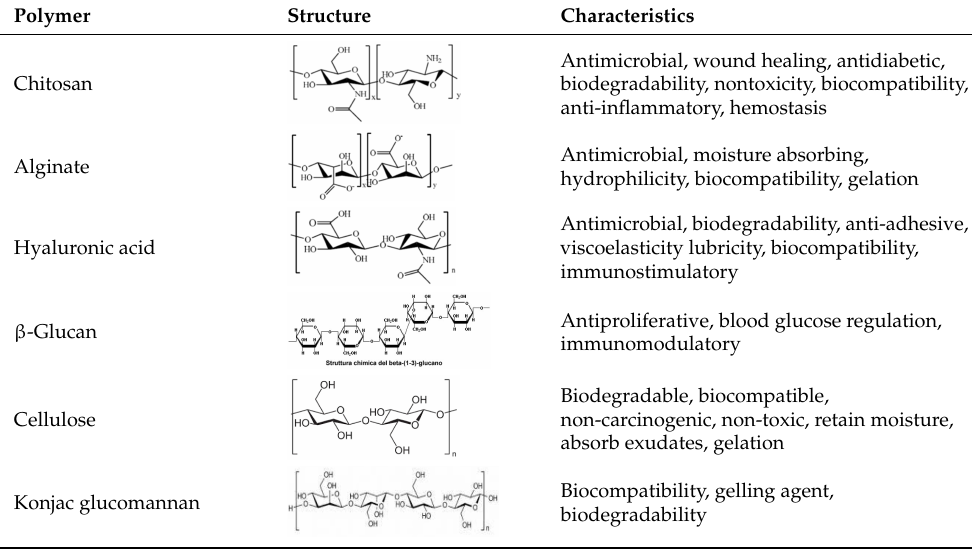
Table 4. Main characteristic of the most important polymeric compounds employed in diabetic wound